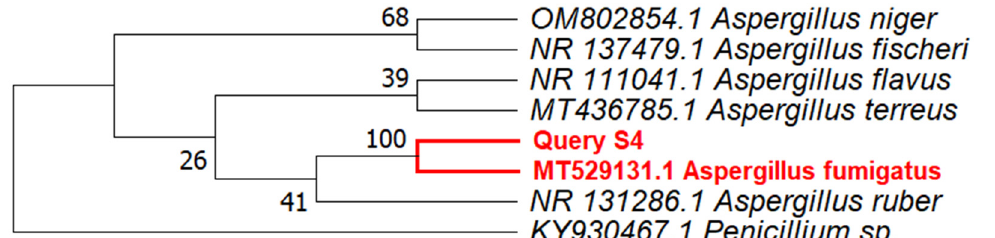
Figure 2. Phylogenetic tree showing the relationship of the ITS sequence of strain S4 with other fungal strains retrieved from the GenBank based on a BLASTn search. The tree was constructed using the neighbor-joining (NJ) method with MEGA 7.0 and using Penicillium sp. as an outgroup. Bootstrap values are based on 1000 replicates.